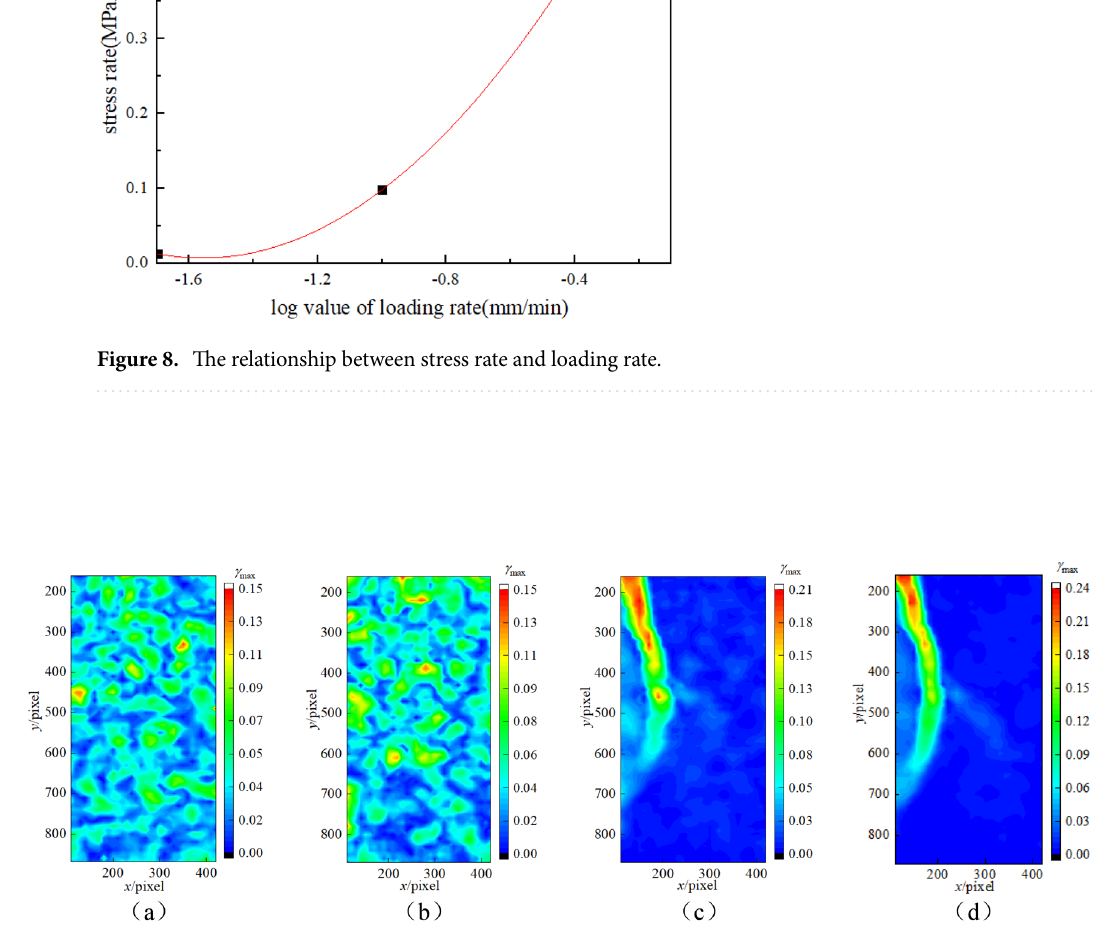
Figure 9. Nephograms of deformation field evolution (0.1